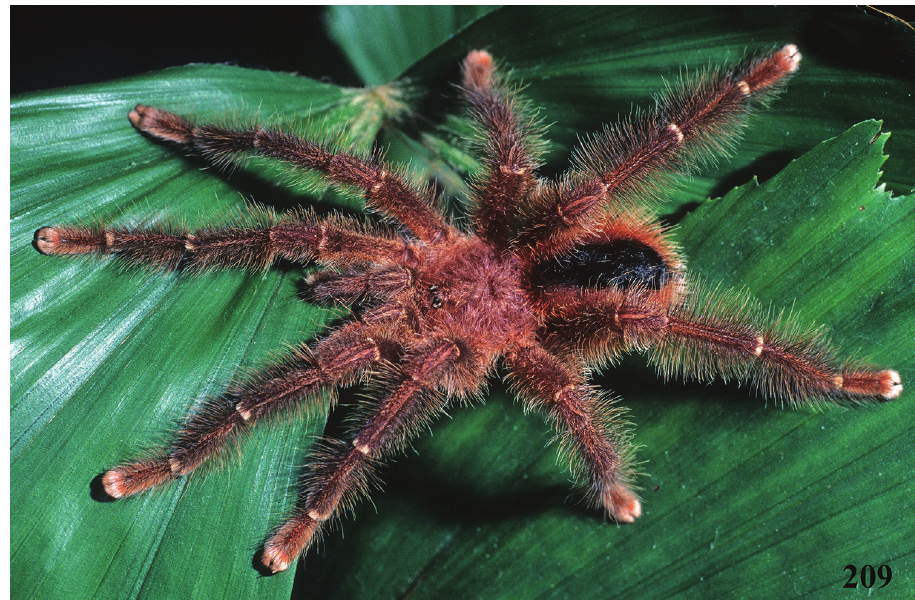
Figure 209. Avicularia lynnae sp. n., habitus, male from department of Loreto, Peru. Photo: R. C. West. Type II urticating setae: 0.73–0.87 long, 0.013–0.019 wide. Palp (Figs 201–204): globous bulb with small subtegulum and developed